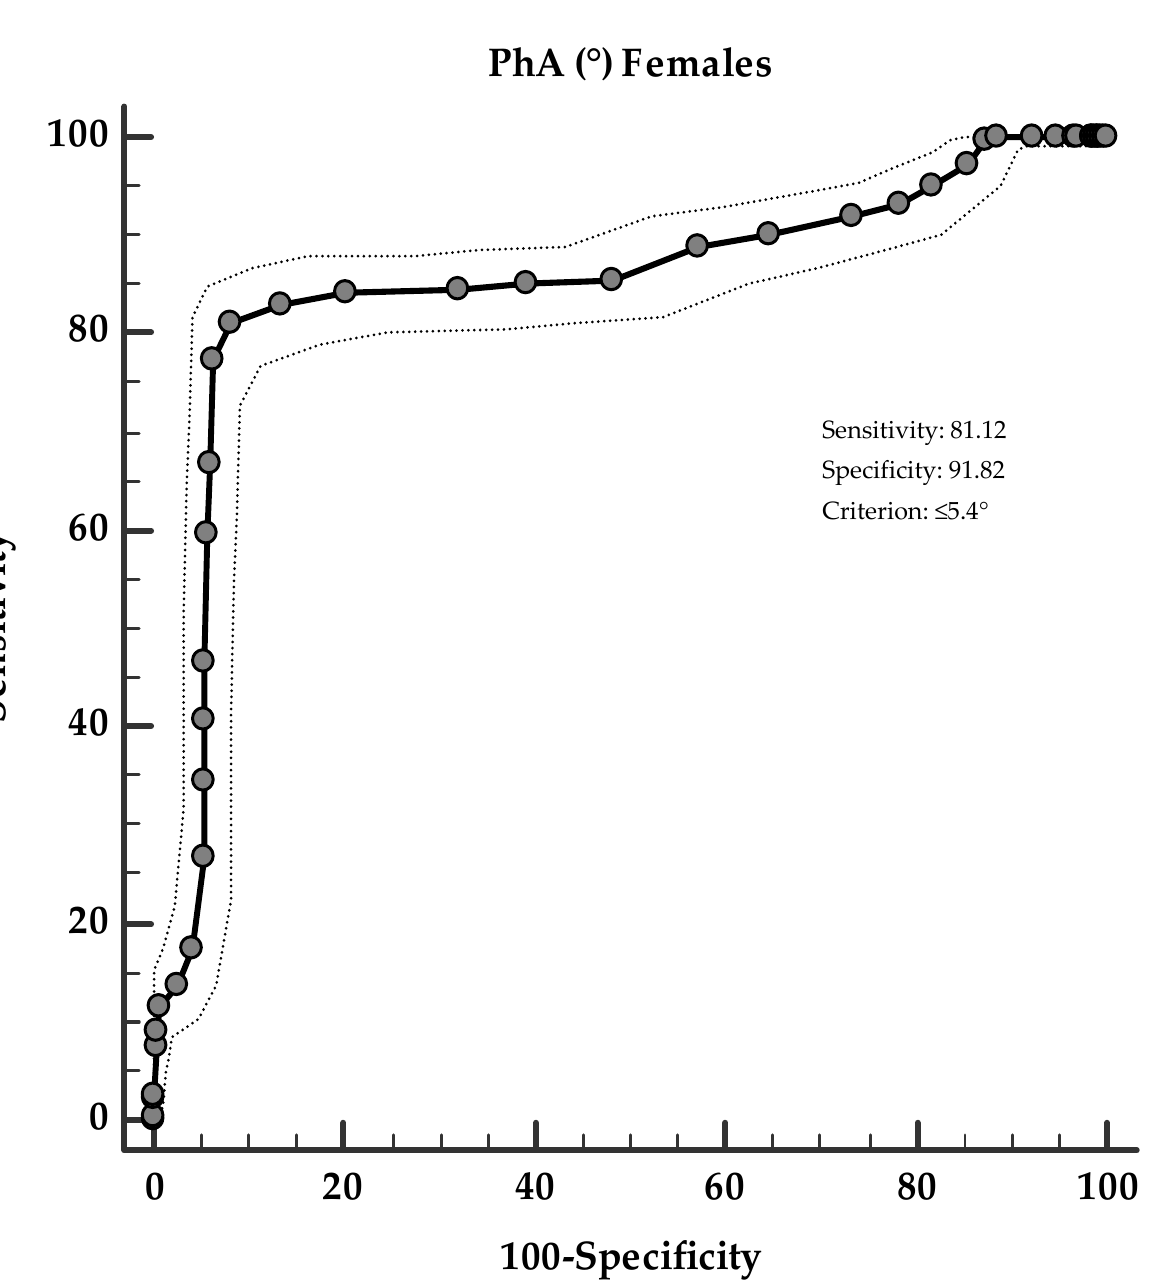
Figure 4. ROC for predictive values of PhA (°) in detecting the highest hs-CRP levels in females. * A significant difference ( p < 0.05).